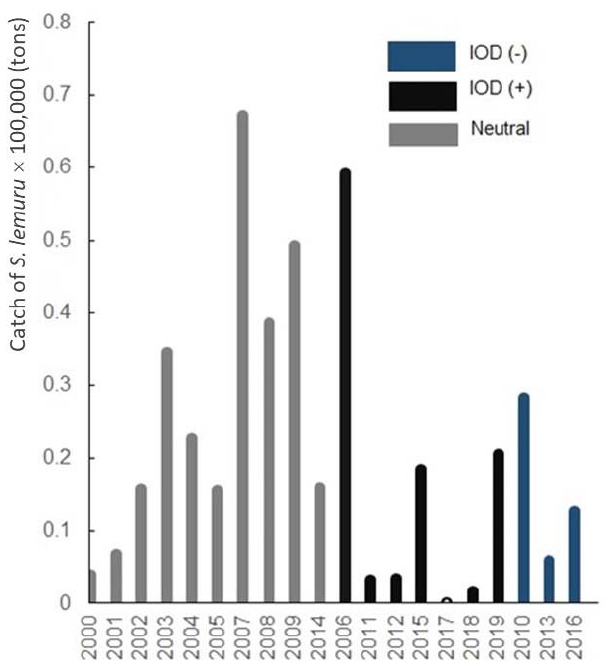
Figure 3. Catches of Sardinella lemuru in the Bali Strait during the neutral conditions and IOD (+) and IOD ( − )